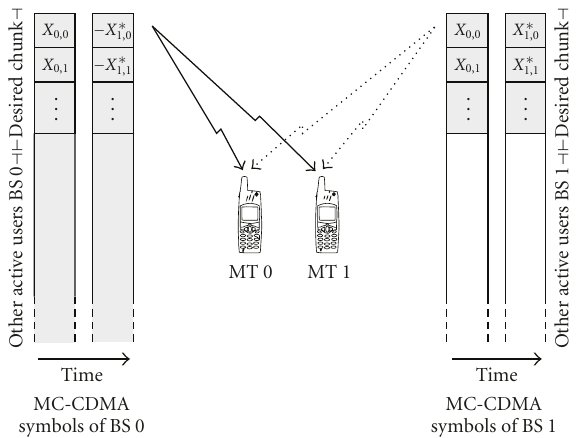
Figure 6: MC-CDMA symbol design for CAT for